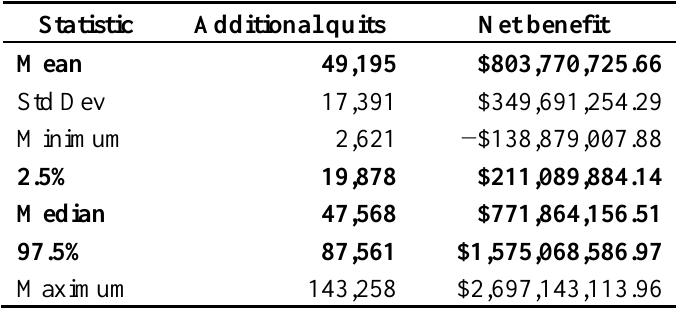
Table 1. Principle simulation results, statistical